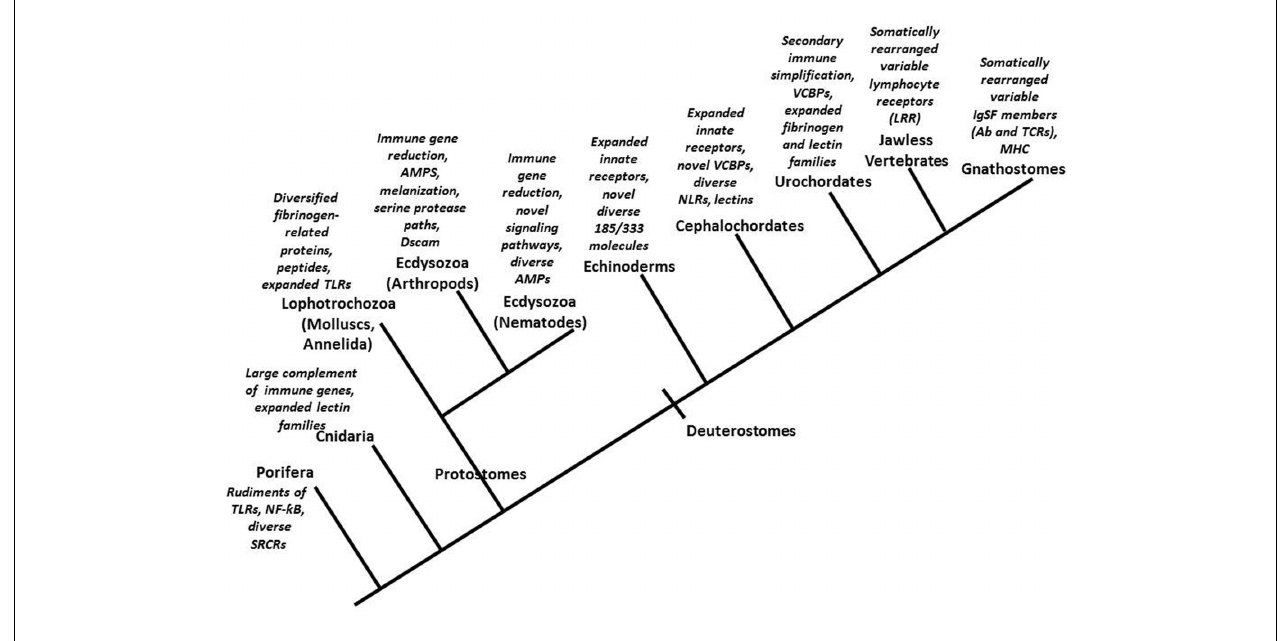
region-containing chitin-binding proteins; NLRs, intracellular NOD-like receptors; LRR, leucine-rich repeat; IgSF, immunoglobulin superfamily; Ab, antibodies;TCR,T cell receptor; MHC, major histocompatibility